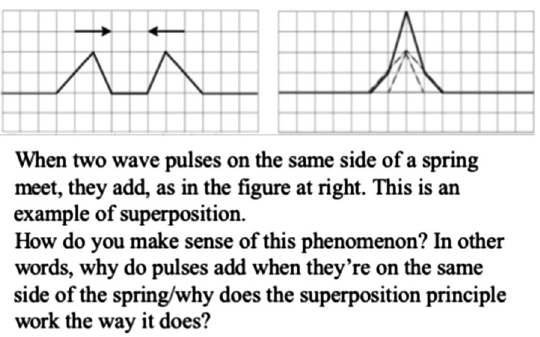
FIG. 6. The explain-style question on superposition of two pulses (the why superposition question).